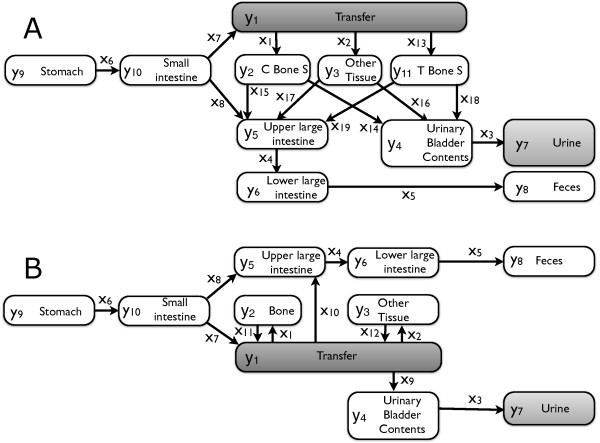
Models for the biokinetics of zirconium.A: ICRP model. The model consists of eleven compartments y1,…,y11and 15 time independent transfer rates x1,…,x8,x13,…,x19. B: HMGU model. The model consists of ten compartments y1,…,y10and twelve transfer rates x1,…,x12. In both models zirconium enters the body in the stomach compartment y9and diffuses through the system until it reaches either one of the two final compartments urine, y7, or feces, y8. The gray compartments y1and y7are directly related to the datasets measured.